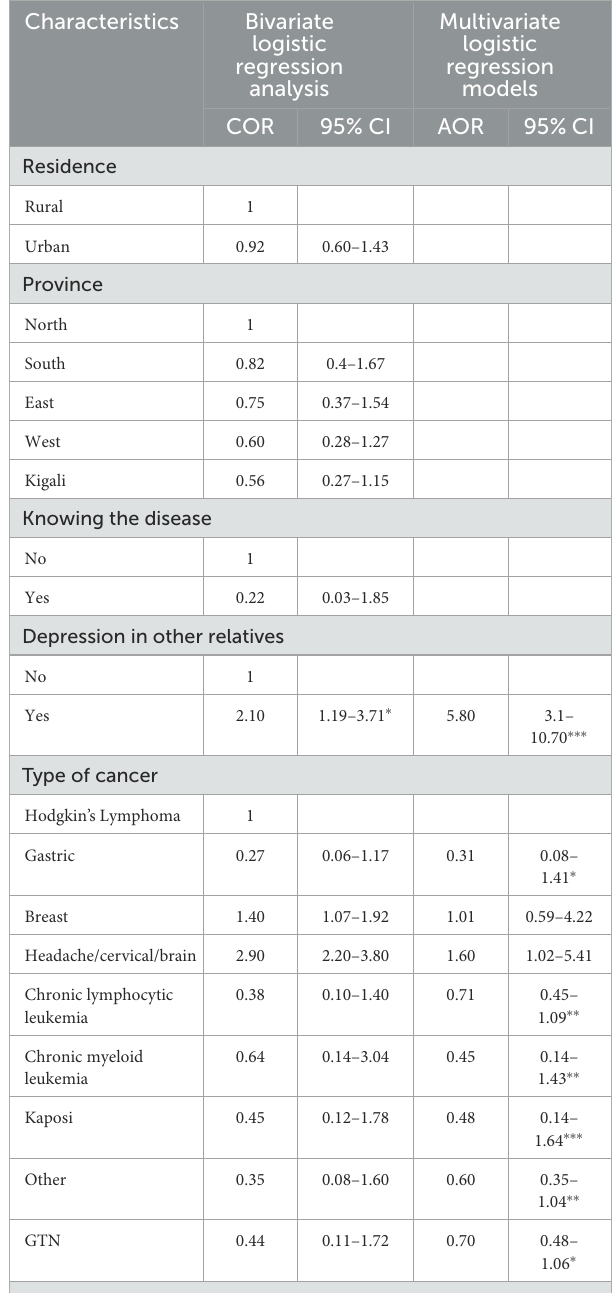
TABLE 3 Bivariate and multivariate logistic regression model analyses for the risk factors for depression.